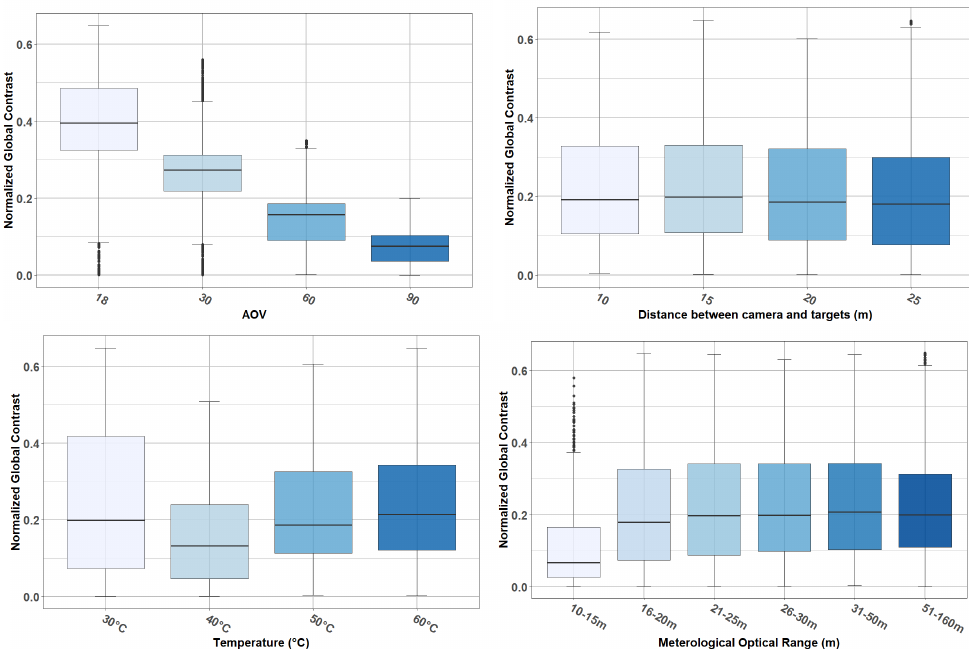
Figure 16. Data collected under foggy weather conditions: contrast distribution with respect to AOV, camera-to-target distance, temperature, and MOR.